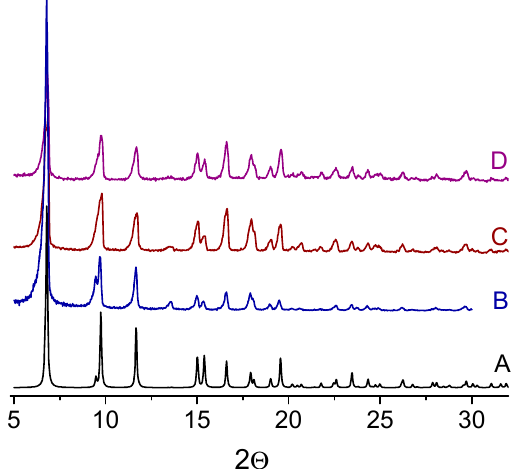
Figure 1. The powder X-ray diffractometry (PXRD) patterns of ( A ) simulated MIL-125, ( B ) MIL-125-M, ( C ) MIL-125-L and ( D ) MIL-125-L after catalysis (reaction conditions as in Table 2, entry 10).